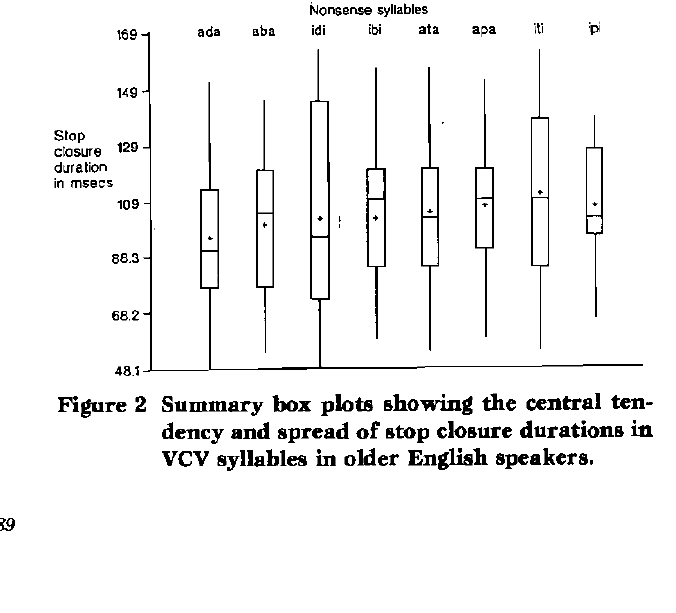
Figure 2 Summary box plots showing the central ten- dency and spread of stop closure durations in VCV syllables in older English